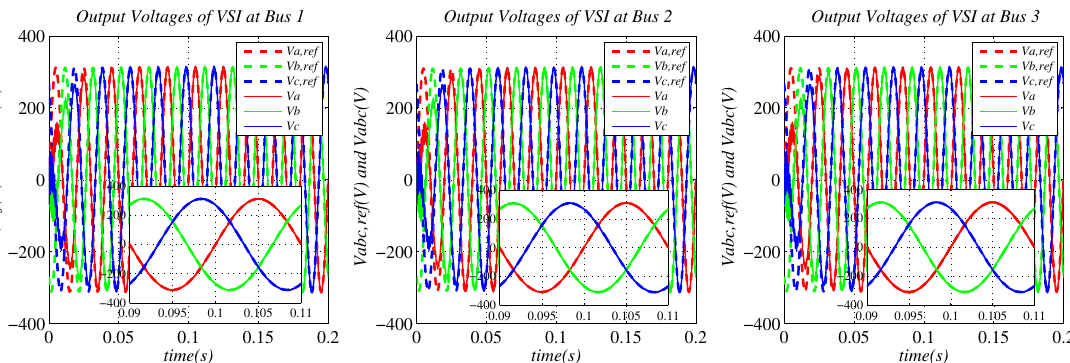
Figure 15. Output voltages of the VSI at Buses 1, 2, and 3 with the nonlinear load in the abc reference